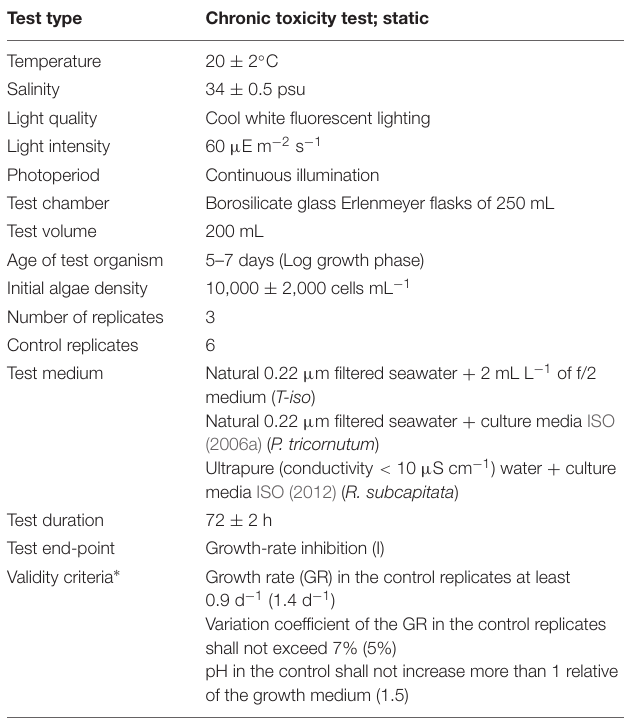
TABLE 1 | Summary of test conditions for the microalgae growth-rate inhibition bioassay.